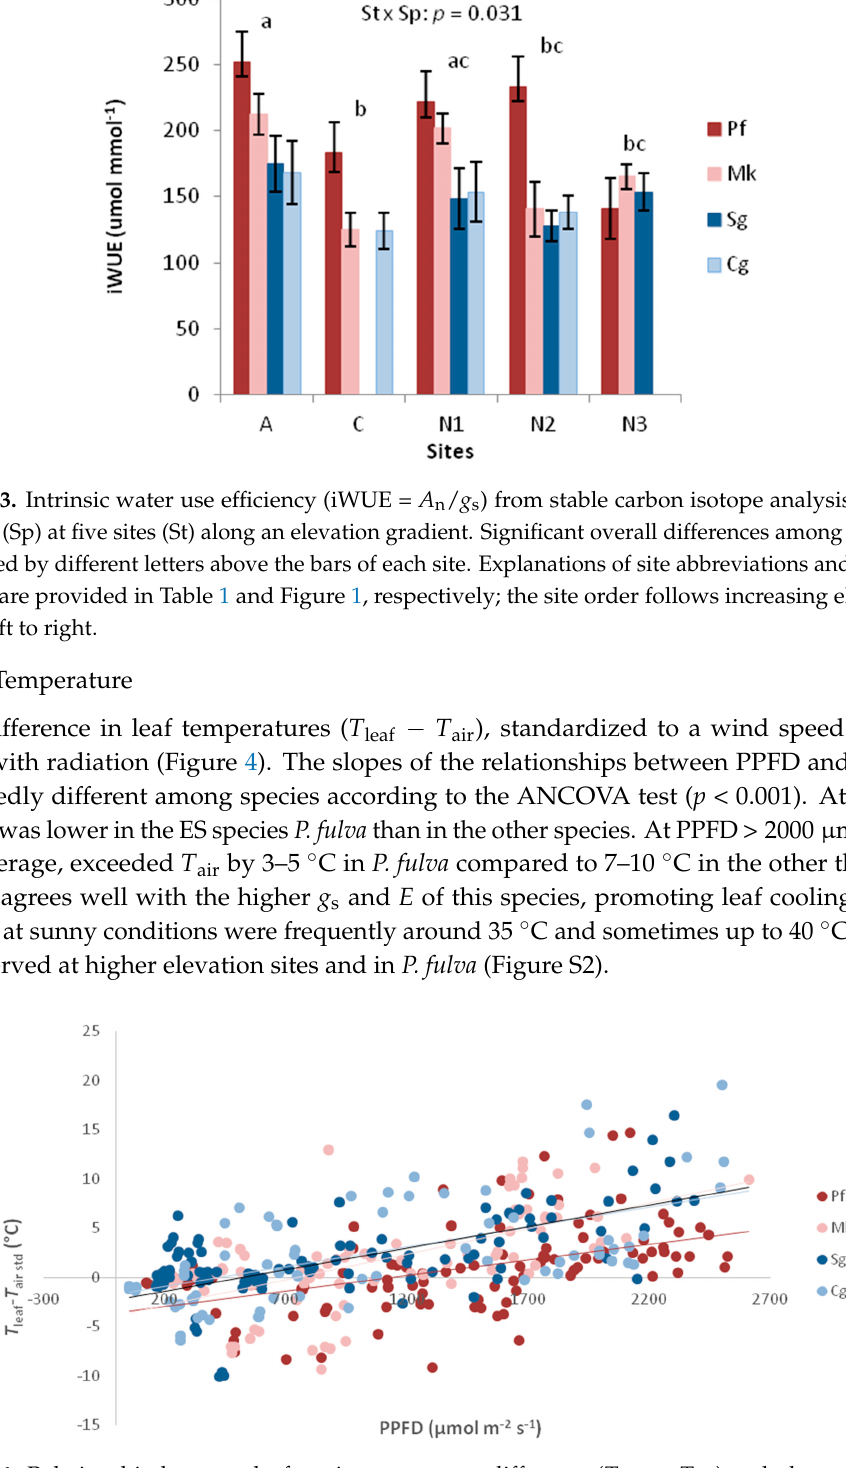
Figure 4. Relationship between leaf to-air temperature difference ( T leaf − T air ) and photosynthetic photon flux density (PFD) for all species in the wet season of 2017, with data pooled across sites. The slopes of the relationships were markedly different among species according to the ANCOVA test ( p < 0.001). Values of T leaf − T air were standardized to a wind speed of 1 m s − 1 (see Materials and methods). Species abbreviations are explained in Figure 1.